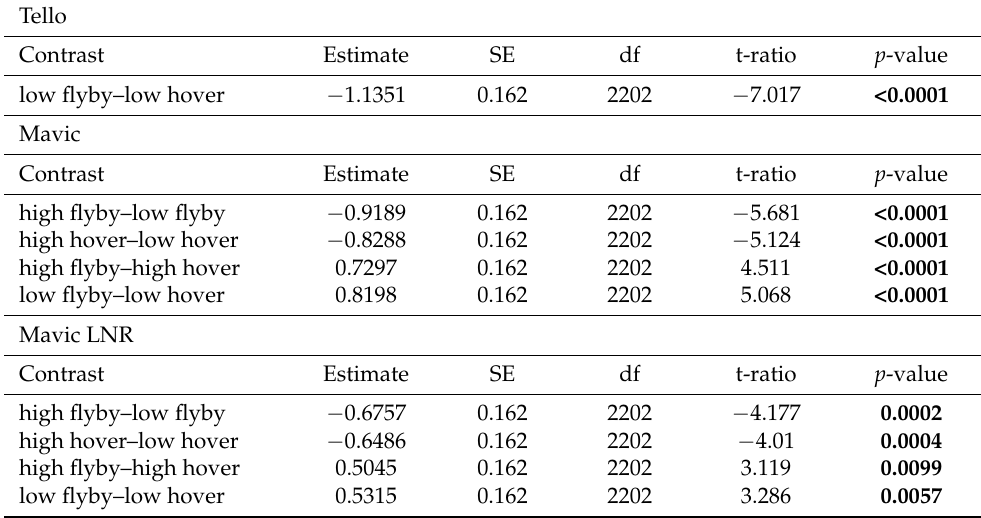
Table A1. Pairwise contrasts of the annoyance ratings within the UAV types. p -values in bold represent statistical significance